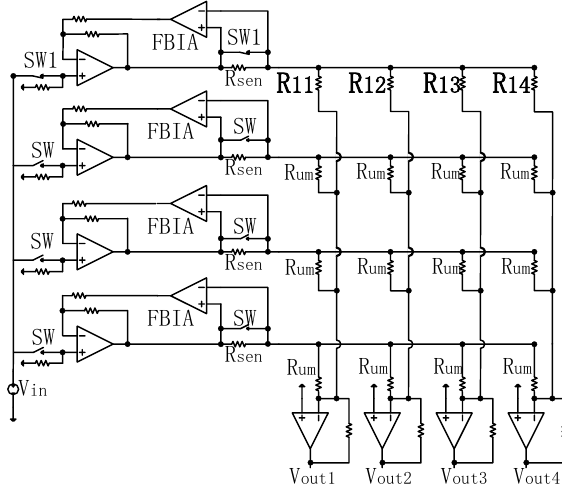
Figure 3. The circuit design of DZCM for a 4 × 4 array.